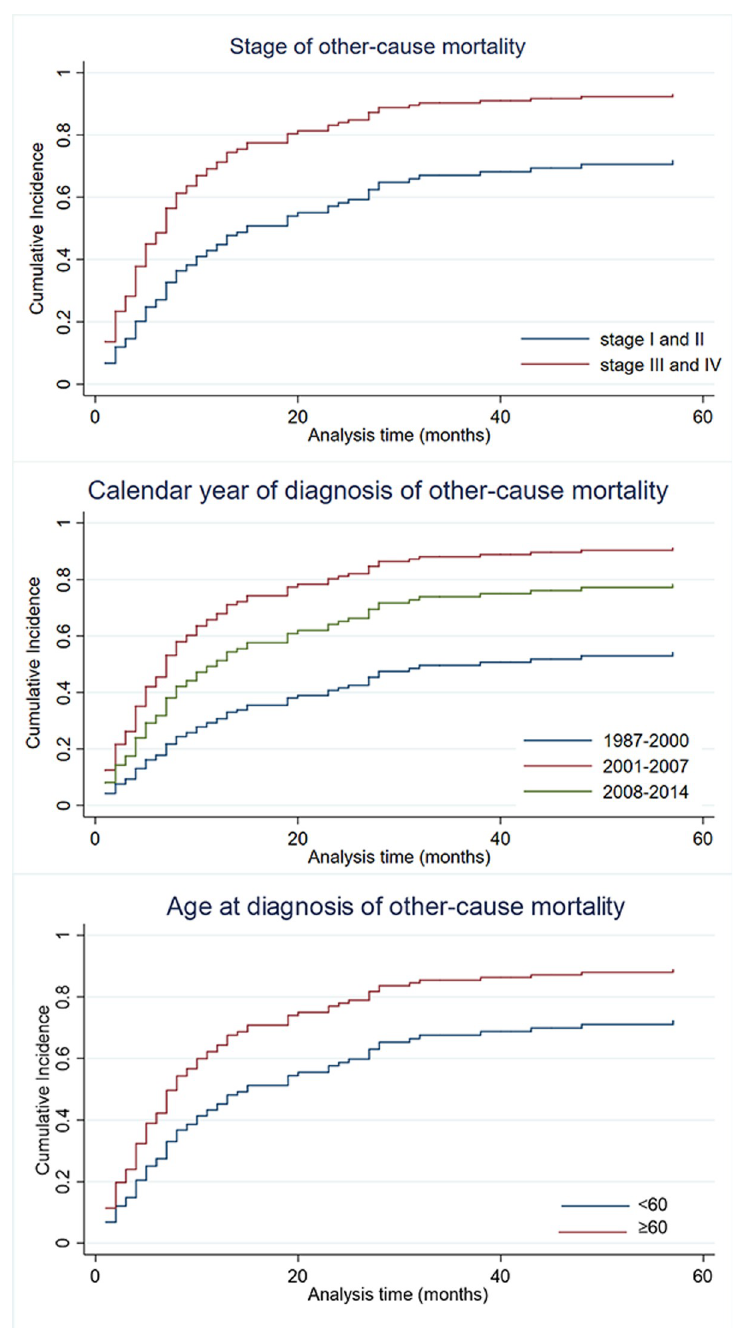
Fig 4. Cumulative incidence plot comparing (A) Ann Arbor stage, (B) calendar year of diagnosis (C) age at diagnosis in other cause mortality.